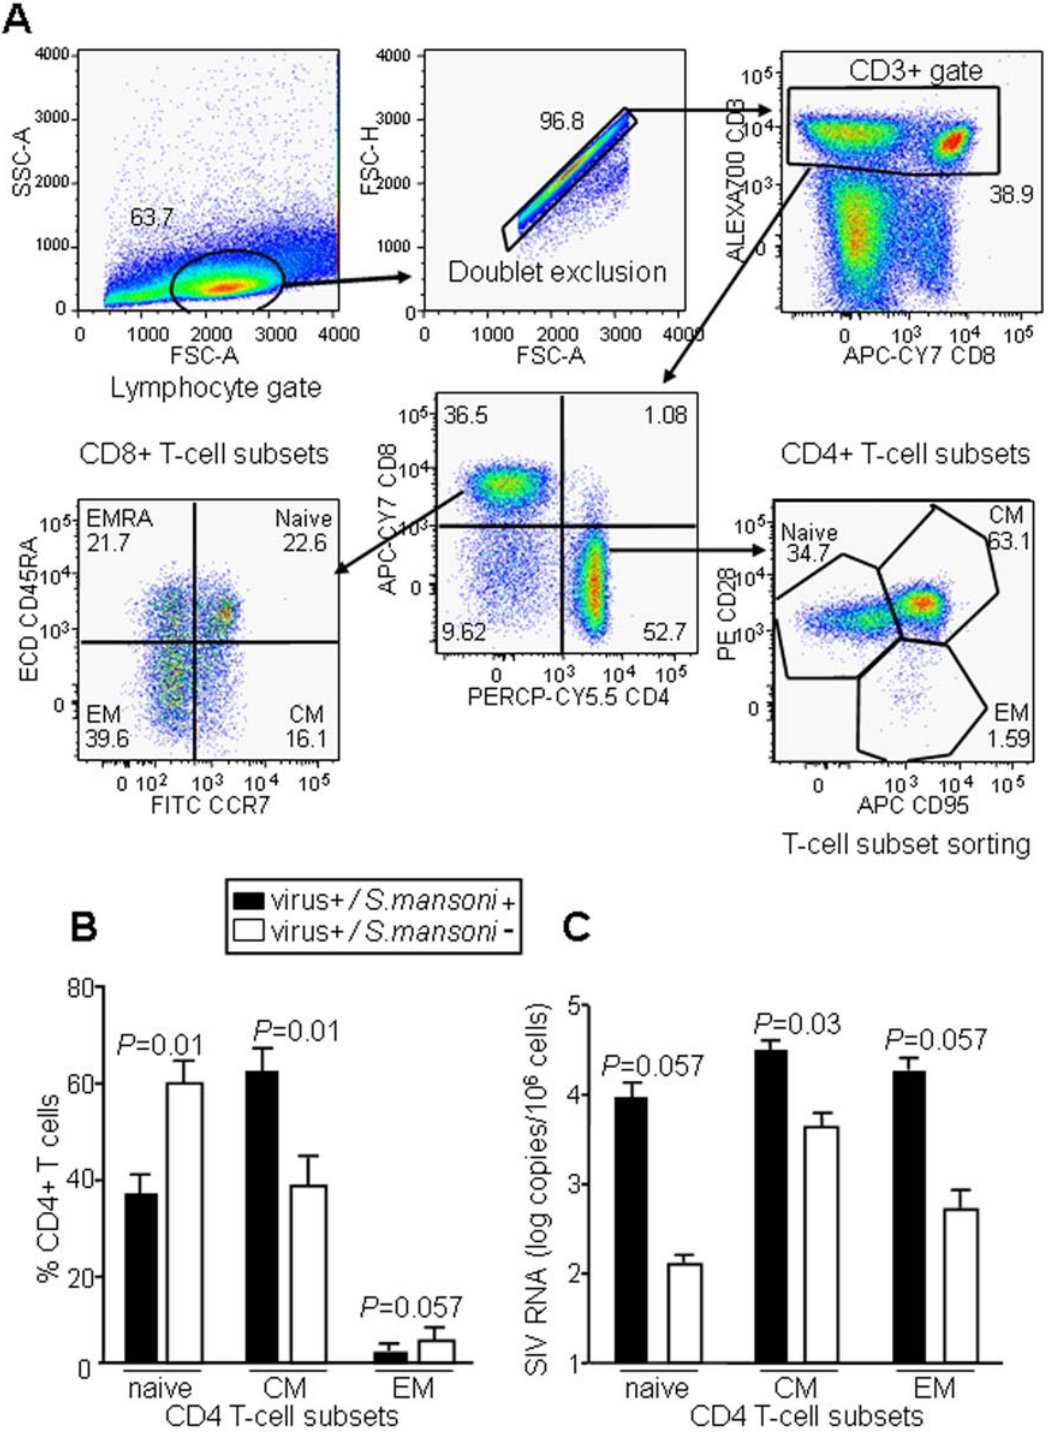
Figure 3. Differences in CD4 + T cell subsets and cell viral loads between animals with S.mansoni /SHIV-C coinfection and SHIV-C infection alone. (A) Phenotyping strategy used to separate naı¨ve, central memory (CM), effector memory (EM) and effector memory CD45RA + (EMRA) T cell subsets. Percentages demonstrate T cell subsets for one of the coinfected monkeys. (B) CD4 + naı¨ve, CM and EM in coinfected and parasite-free monkeys. (C) SHIV-C RNA detected in CD4 + naı¨ve, CM, and EM T cells after sorting. For panels (B) and (C), group means and standard deviations are represented.